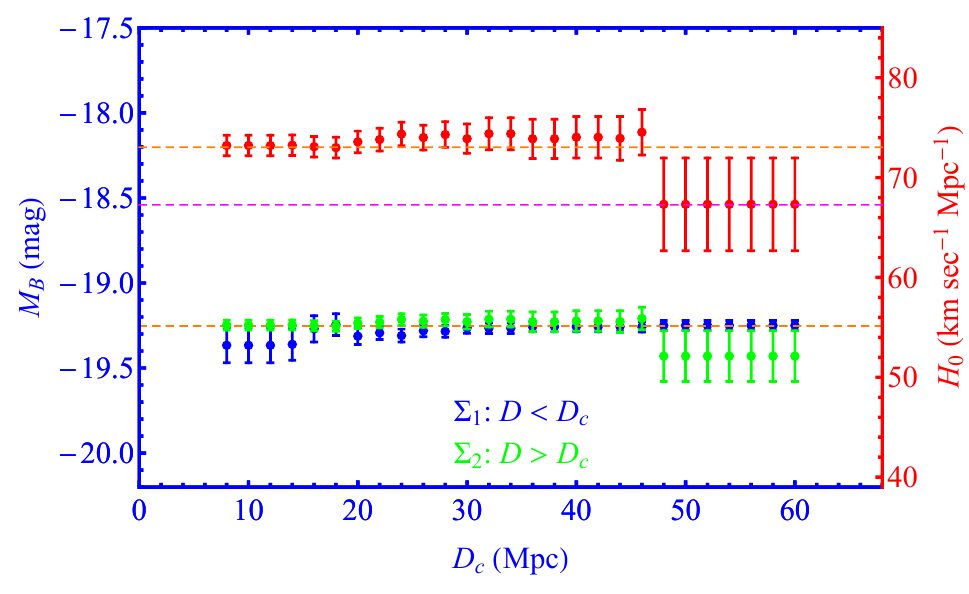
Figure 8. The best-fit values with uncertainties for the high–low D bin of SnIa absolute magnitude M B (green and blue points) and for H 0 (red points). This generalization of the SH0ES baseline analysis allows for a transition of M B . The best-fit parameter values as shown as functions of the critical transition D c . Dotted lines correspond to the SH0ES R21 best fit and to the Planck18/ Λ CDM best fit for H 0